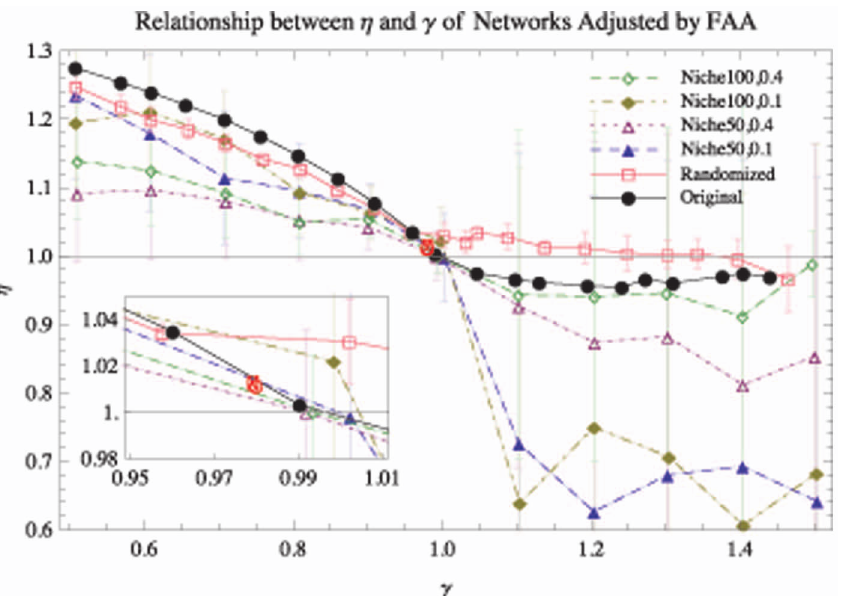
Figure 4. The relationship between c and g according to the flow adjusting algorithm (FAA) applied to the Mondego ecological network, the randomized Mondego flow network, and the networks generated by the Niche Model. The black filled circles and red hollow squares are the original and randomized Mondego flow networks, respectively. The randomized flow network retains the topological structure of the Mondego network but assigns the flux randomly. The other dashed curves are for the networks generated by the Niche model [40] with different numbers of nodes (100 or 50) and connectances (0.4 or 0.1), as well as for the randomly assigned flows. The FAA is applied to all these flow networks to obtain the relationships between g and c . All the exponents represent the averages of the results of 50 random experiments. The red star(‘‘*’’) shows the original positions of the dissipation law exponent (0.980) and the allometric exponent (1.012) of the Mondego network. The red open circle corresponds to the combination of the original dissipation law exponent (0.980) and the adjusted allometric exponent (1.011) according to the FAA for the Mondego network.